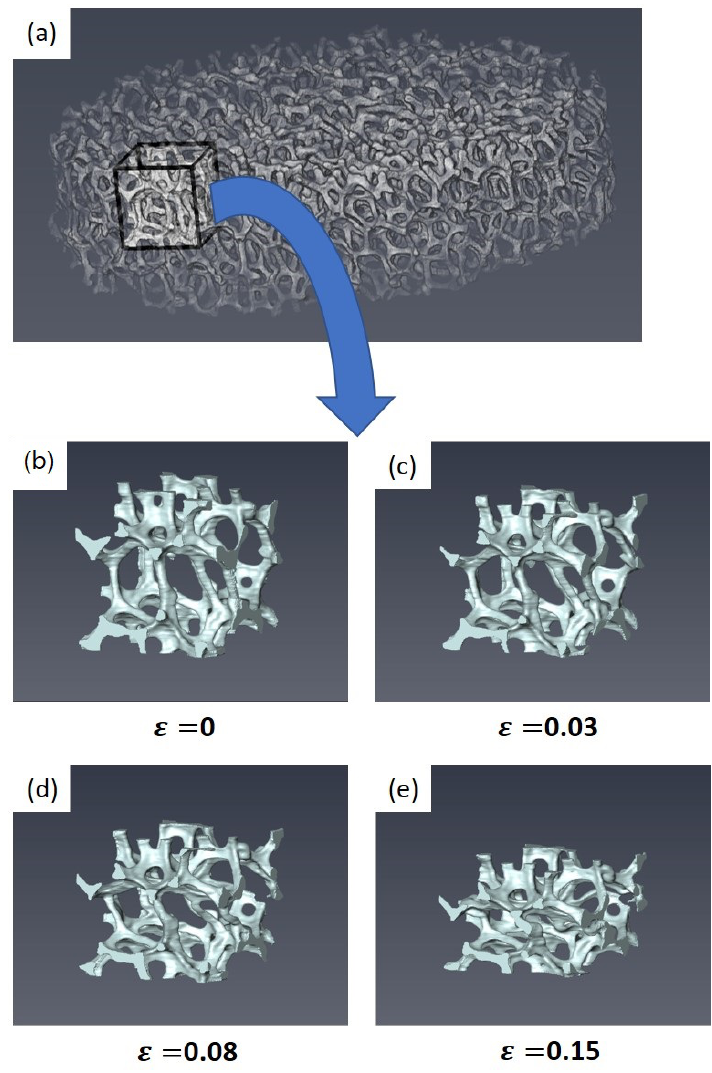
Figure 10. Observed microstructural evolution of the selected geometry of interest with strain during ex-situ compression